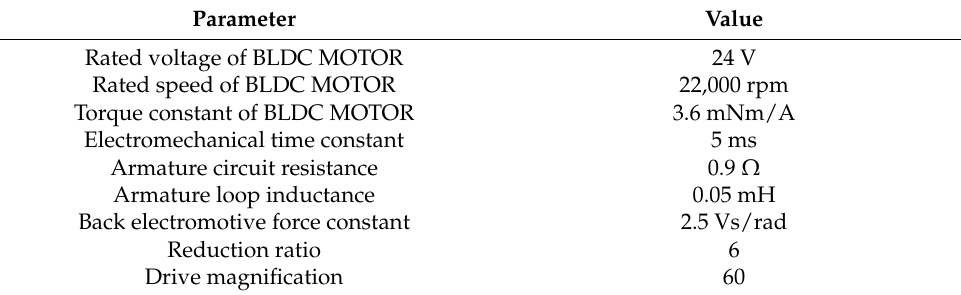
Table 1. Parameters of the EMA